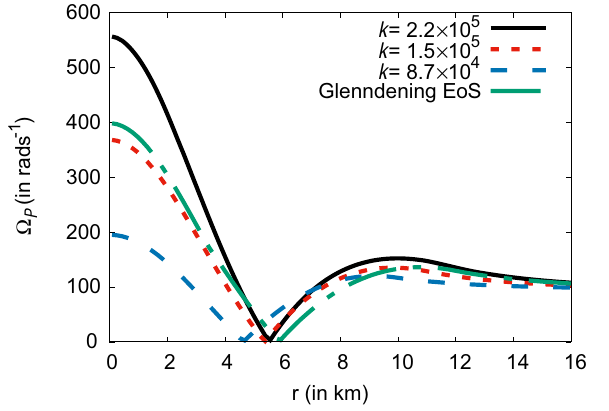
Fig. 18 Ω P ofthegyroaroundNSs( ω = 700rads − 1 )offourdifferent EoSisshown.Thegyro’sorbitalfrequencyistakenas Ω = 100rads − 1 . The black solid line is for a stiff polytropic star. The red short dashed curveisforastandardpolytropicstar.Thebluedashedlineisforasofter polytropic EoS and the green dot dashed curve is for Glendenning EoS